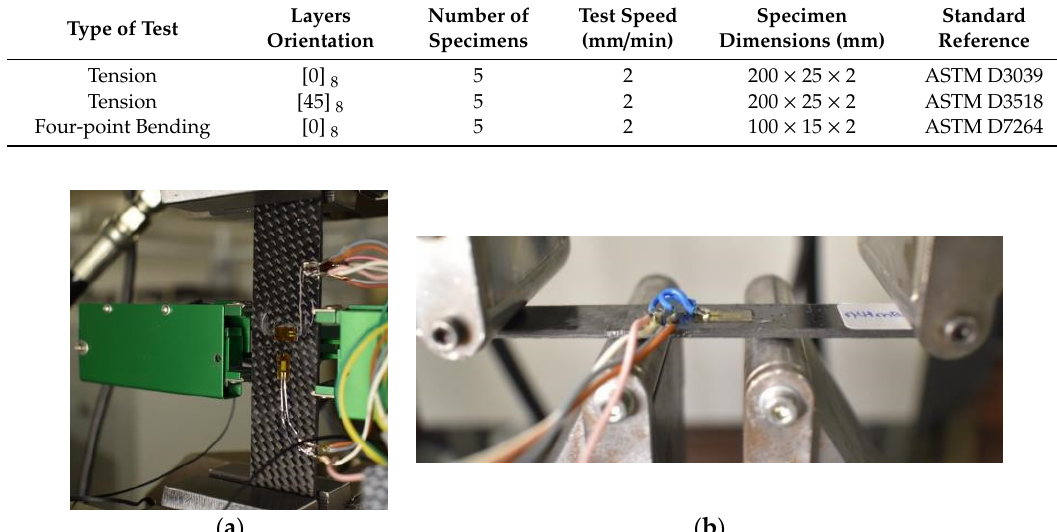
Table 2. Static characterization: Specifications of the experimental tests.